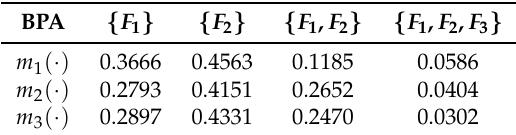
Table 9. The collected sensor reports at the frequency of 3 X modeled as